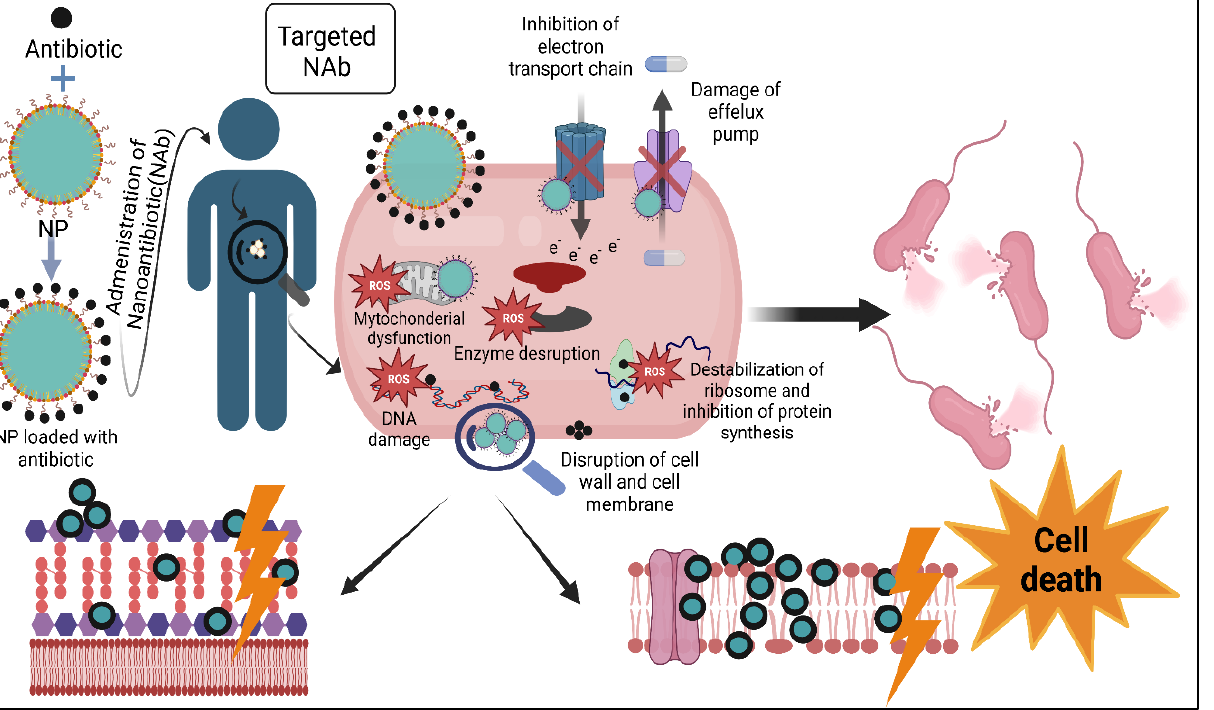
Figure 1. Loading NPs with conventional antibiotics. NPs act as a delivery system to transfer Ab to its target in resistant microorganism. This provides dual mechanisms to combat MDR organism through the effect of Ab and the effect of NPs itself with net result potentiation of bacterial cell death. Abs exert their bactericide effect through disruption of bacterial cell wall or cell membrane, destabilization of ribosomes and inhibition of protein synthesis or inhibition of nucleic acid synthesis. NPs may act through more than one mechanism; disruption of cell wall and cell membrane, mitochondrial damage, enzyme damage, protein damage, efflux pump damage, inhibition of electron transport chain and production of ROS that generate oxidative stress and lead to damage of vital cellular